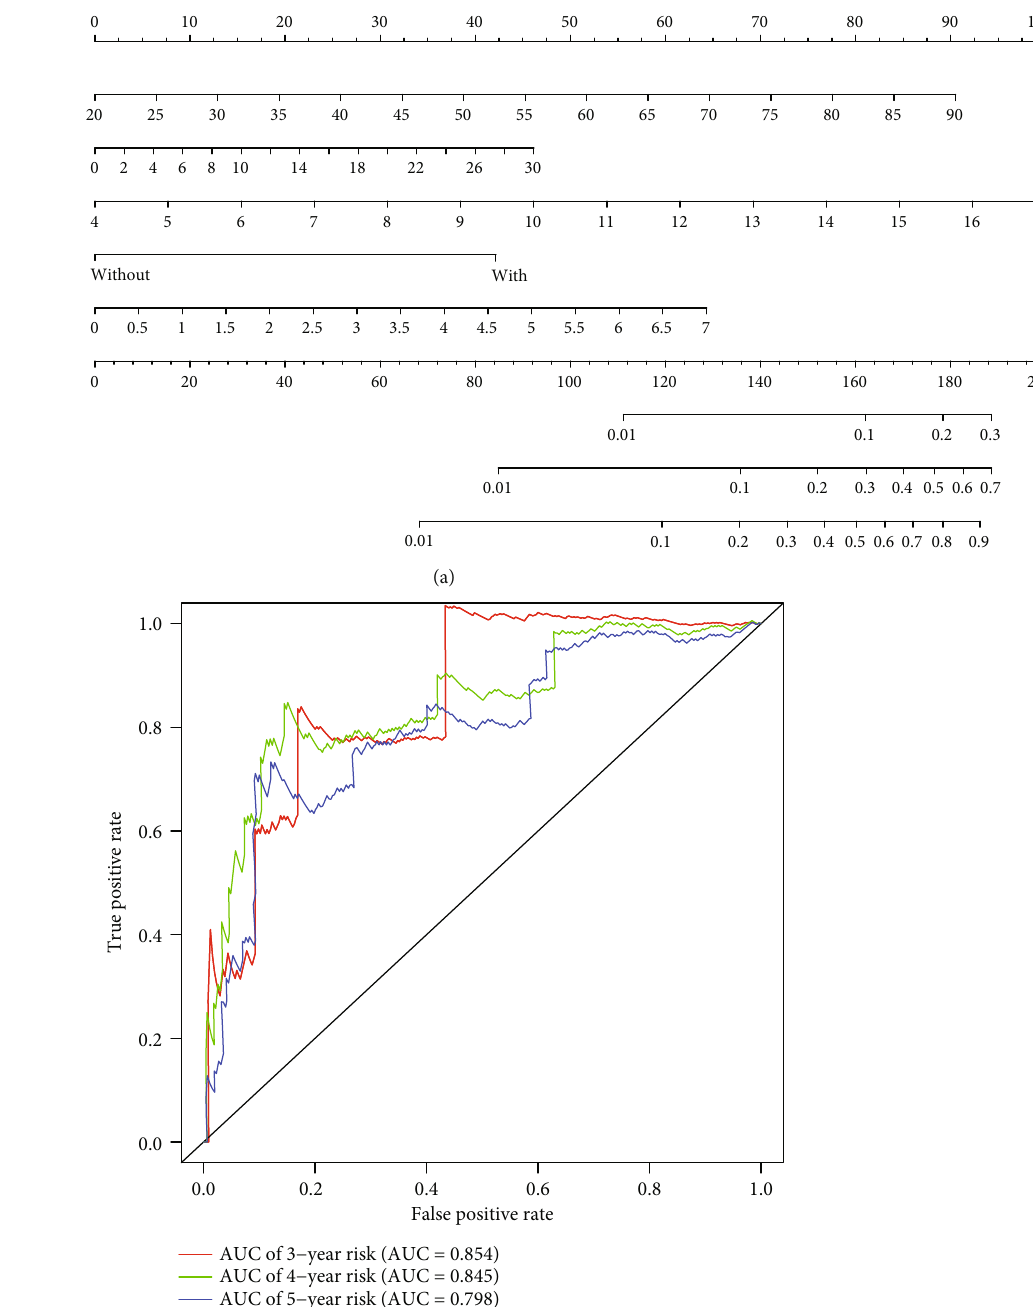
Figure 2: DR prediction model for T2DM patients. (a) Clinical parameter-based nomogram integrating age, diabetes duration, HbA1c, albuminuria, and triglyceride to predict 3-, 4-, and 5-year risks of DR development in patients with T2DM. (b) Time-dependent ROC curves of the nomogram showed AUCs for DR prediction models of 3, 4, and 5 years were 0.854, 0.845, and 0.798, respectively. HbA1c: hemoglobin A1c; AUC: area under the ROC curve; ROC: relative-operating